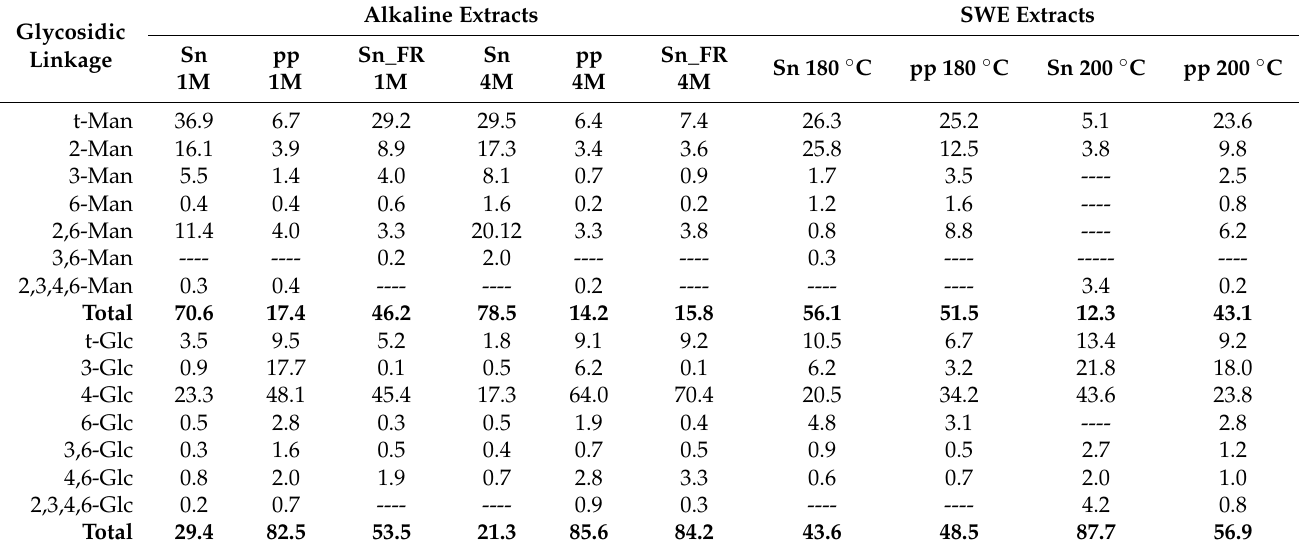
Table 2. Glycosidic linkage composition (molar %) of brewer’s spent yeast extracts.